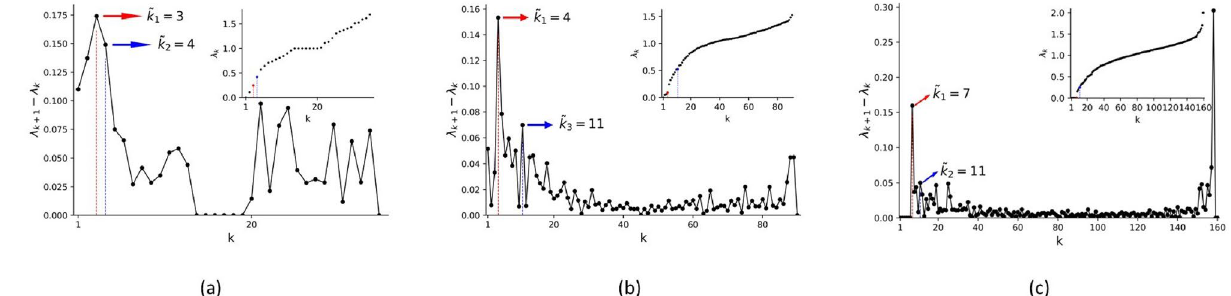
Figure 3. Eigengaps for the Karate club cluster ( a ), AAL90 brain atlas ( b ), and Dosenbach brain atlas ( c ). The red lines highlight the highest gap for each case, while the blue line the second highest gap. For the AAL (in b ), the second eigengap is directly visible thus we explicitely mark the third. Last eigenvalues are not taken into consideration.